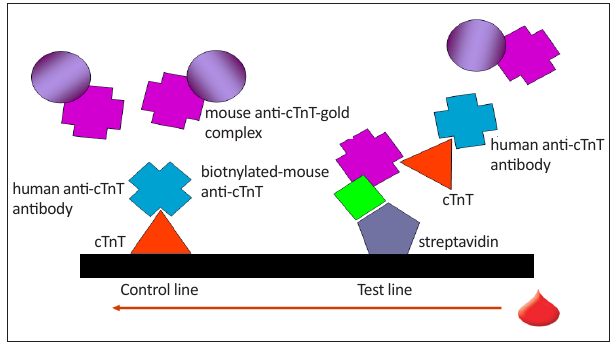
FIGURE 2: Possible effect of blocking human anti-cardiac troponin T antibodies on the Roche CARDIAC Troponin T Quantitative lateral flow immunoassay .